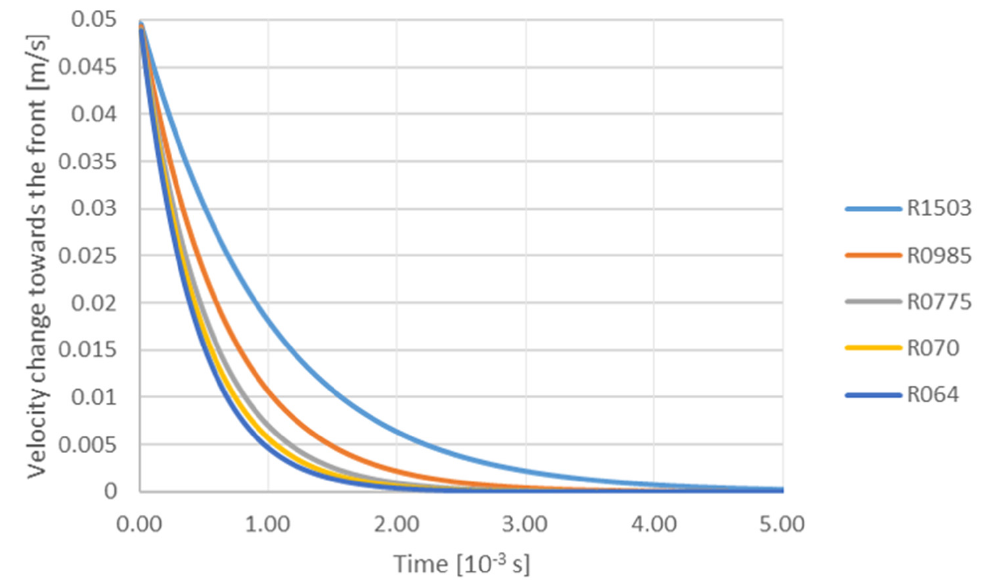
Figure 5. Analysis of influence of TiC particle size on the velocity change towards the front depending on time with a constant gradient 0.00001 m/s and viscosity 0.0013 Pa·s: R064—6.40 × 10 − 8 m; R070—7.00 × 10 − 8 m; R0775—7.75 × 10 − 8 m; R0985—9.85 × 10 − 8 m; R1503—15.03 × 10 − 8 m.